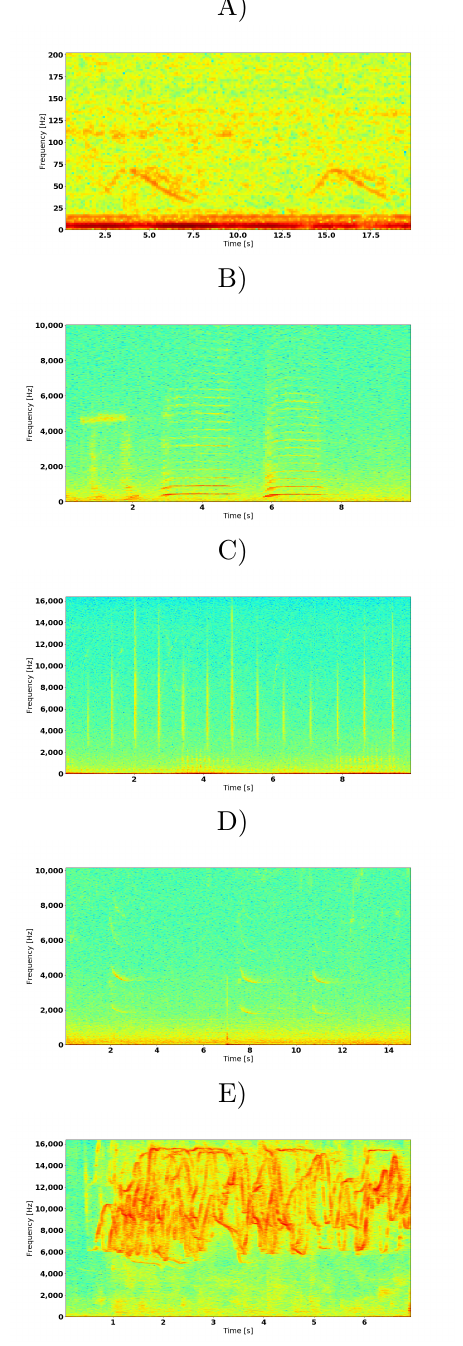
Figure 4. Spectrograms of different species encountered near Saint-Pierre-and-Miquelon (SPM) archipelago: ( A ) blue whale vocalization (frequency resolution = 2 Hz, time resolution = 0.5 s); ( B ) humpback whale vocalization (frequency resolution = 8 Hz, time resolution = 0.125 s); ( C ) sperm whale click train (frequency resolution = 16 Hz, time resolution = 0.0625 s); ( D ) killer whale (frequency resolution = 8 Hz, time resolution = 0.125 s); ( E ) delphinids (frequency resolution = 8 Hz, time resolution = 0.03